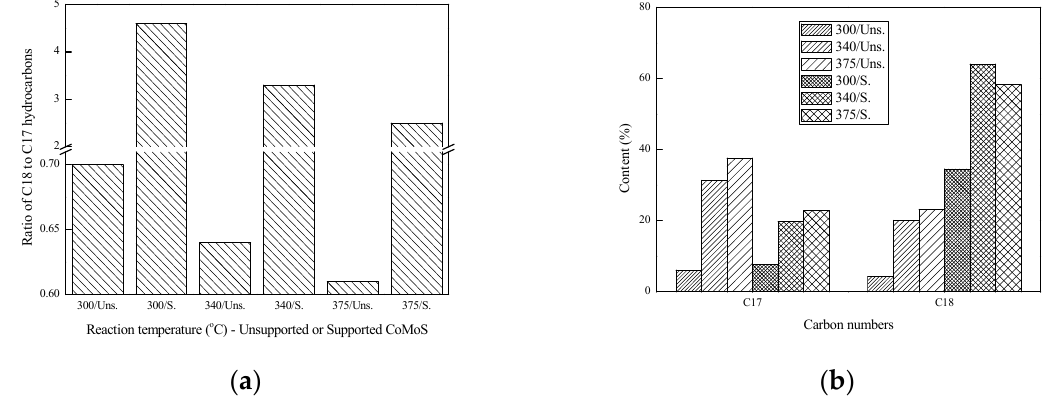
Figure 5. C17 and C18 distributions in WCO hydrotreated liquid products. ( a ) Mass ratio of C18/C17 hydrocarbons. ( b ) C17 and C18 distributions.